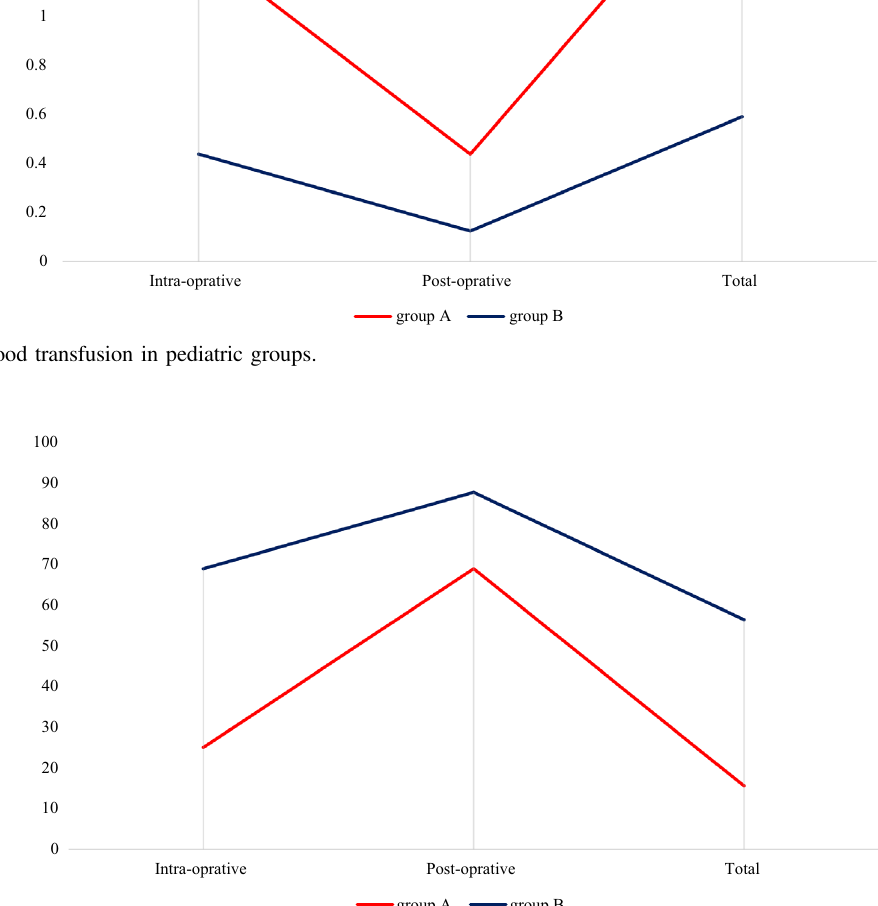
Figure 4. Percentage of pediatric patients who avoided